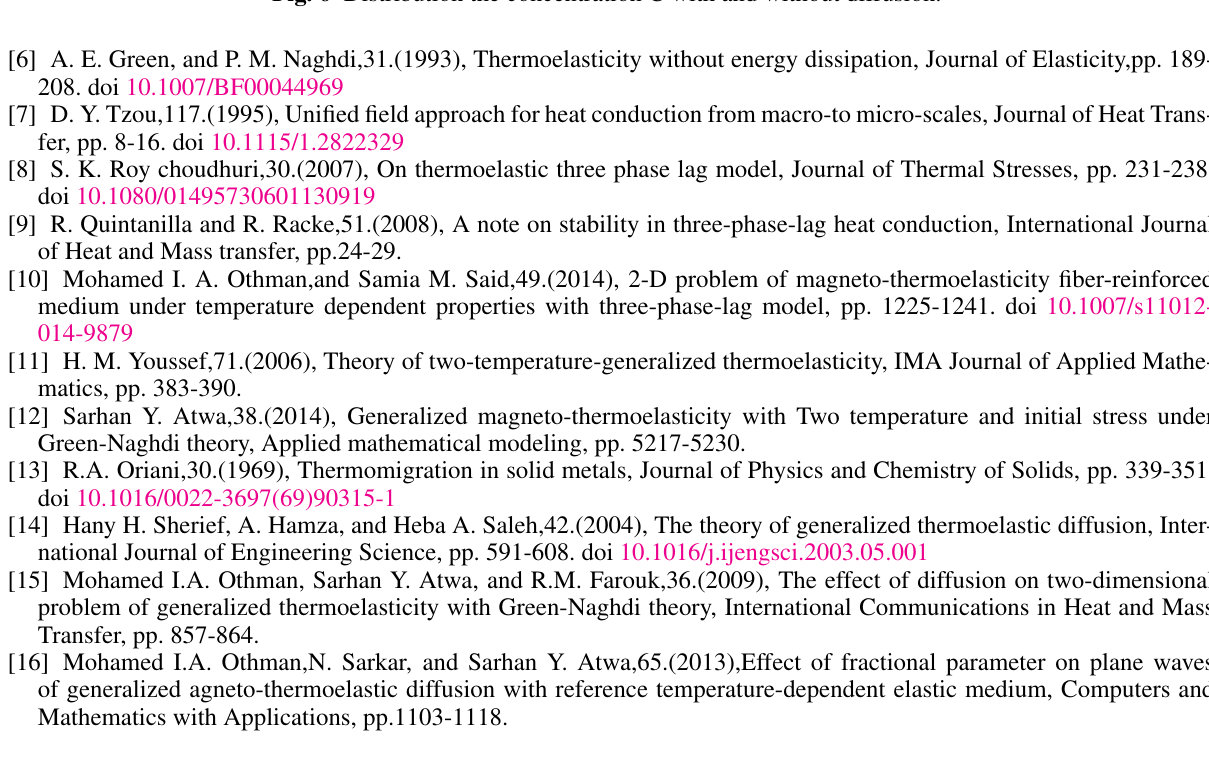
Fig. 6 Distribution the concentration C with and without